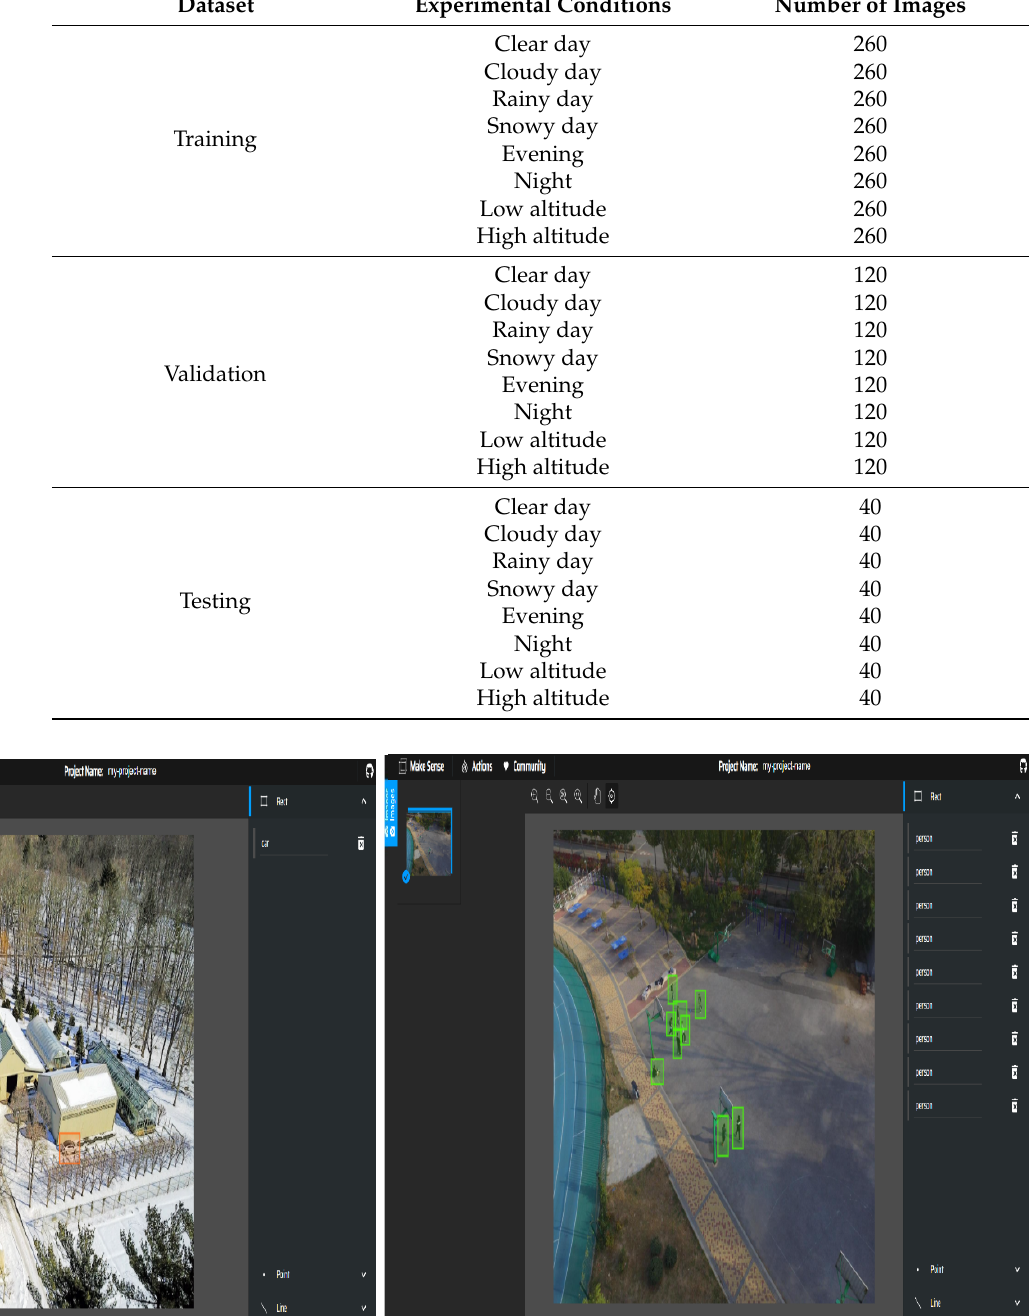
Table 1. Dataset classification by various experimental conditions.